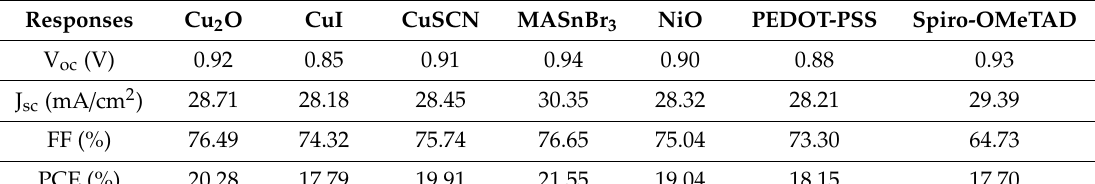
Figure 4. Band alignment between ETL materials and MASnI 3 perovskite.